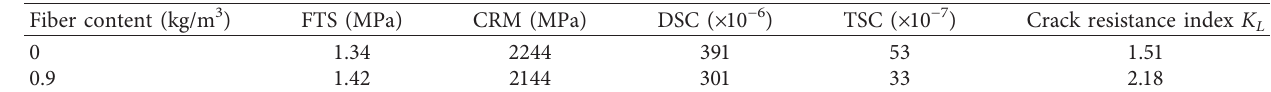
Figure 20: The stress mode of CSM base Table 6: Crack resistance index.